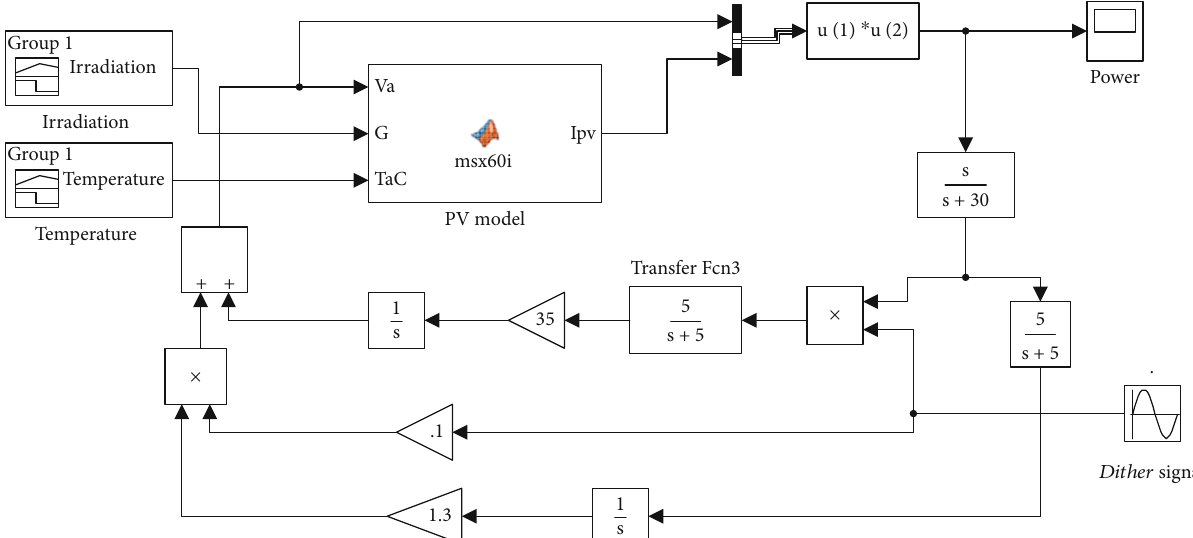
Figure 10: Simulink model of the modi fi ed ESC applied to the PV system.